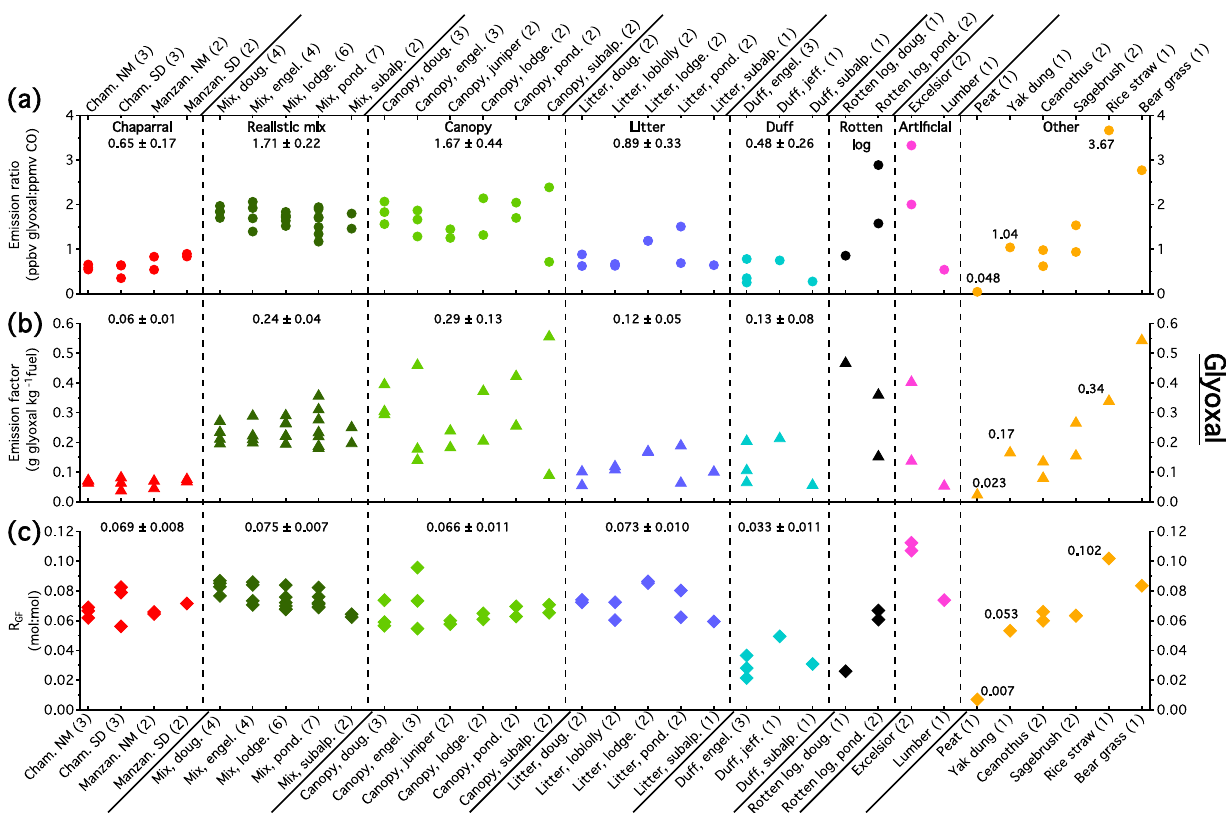
Figure 3. (a) Glyoxal emission ratios in units of ppbv glyoxal(ppmv CO) − 1 for the different fuel types. The number in the label denotes the number of replicate burns for a given fuel type, while each marker represents the value for an individual fire. (b) Glyoxal emission factors in units of g glyoxal(kg fuel) − 1 . (c) The glyoxal to formaldehyde ratio, R GF , calculated using formaldehyde data from the OP-FTIR. For the first five groups, the average and standard deviation of all the burns in that group are shown. For the last three groups, averages are not provided due to the small number of samples and because the fuels in “other” are